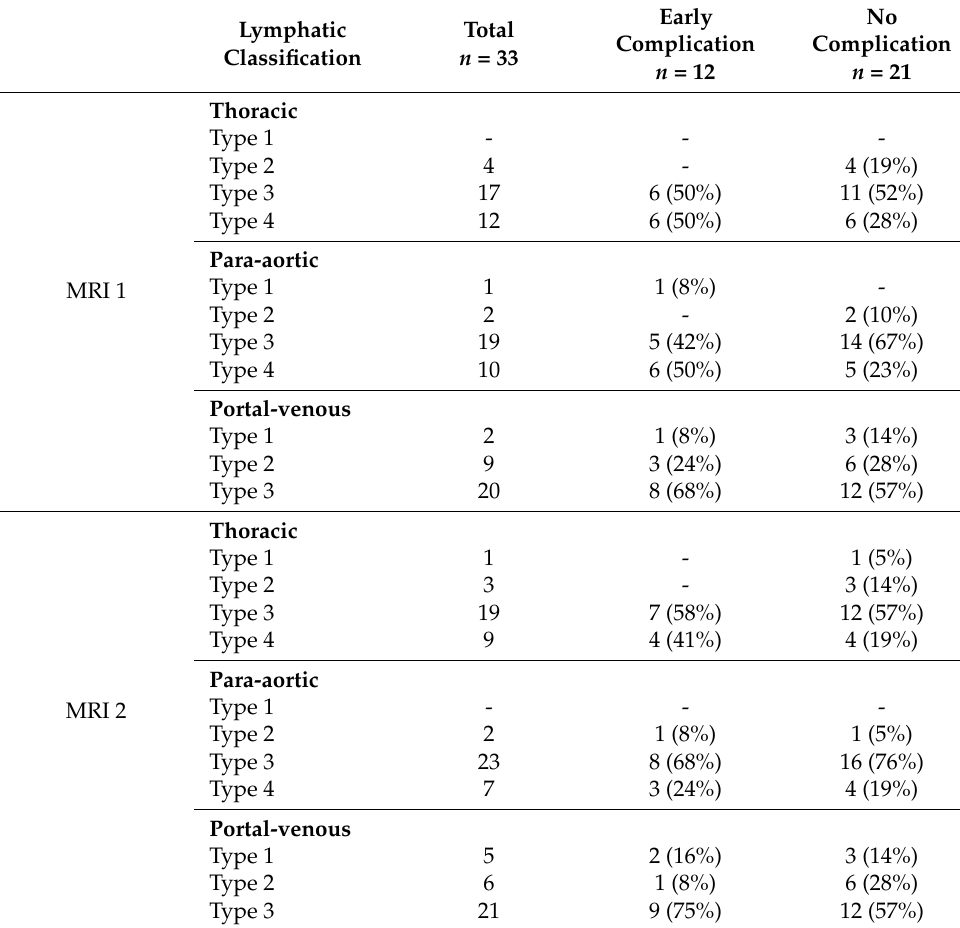
Table 3. Early complications and lymphatic